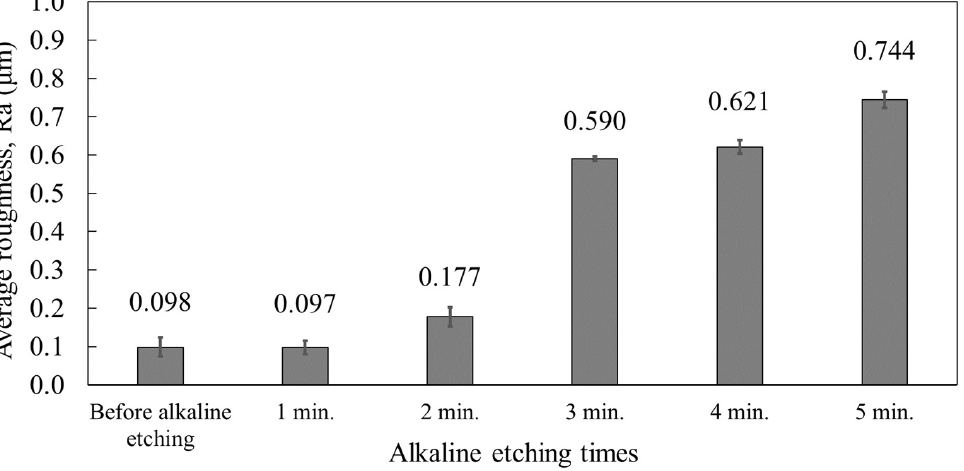
Figure 2. Average roughness Ra of an A535 alloy after mechanical polishing and alkaline etching.